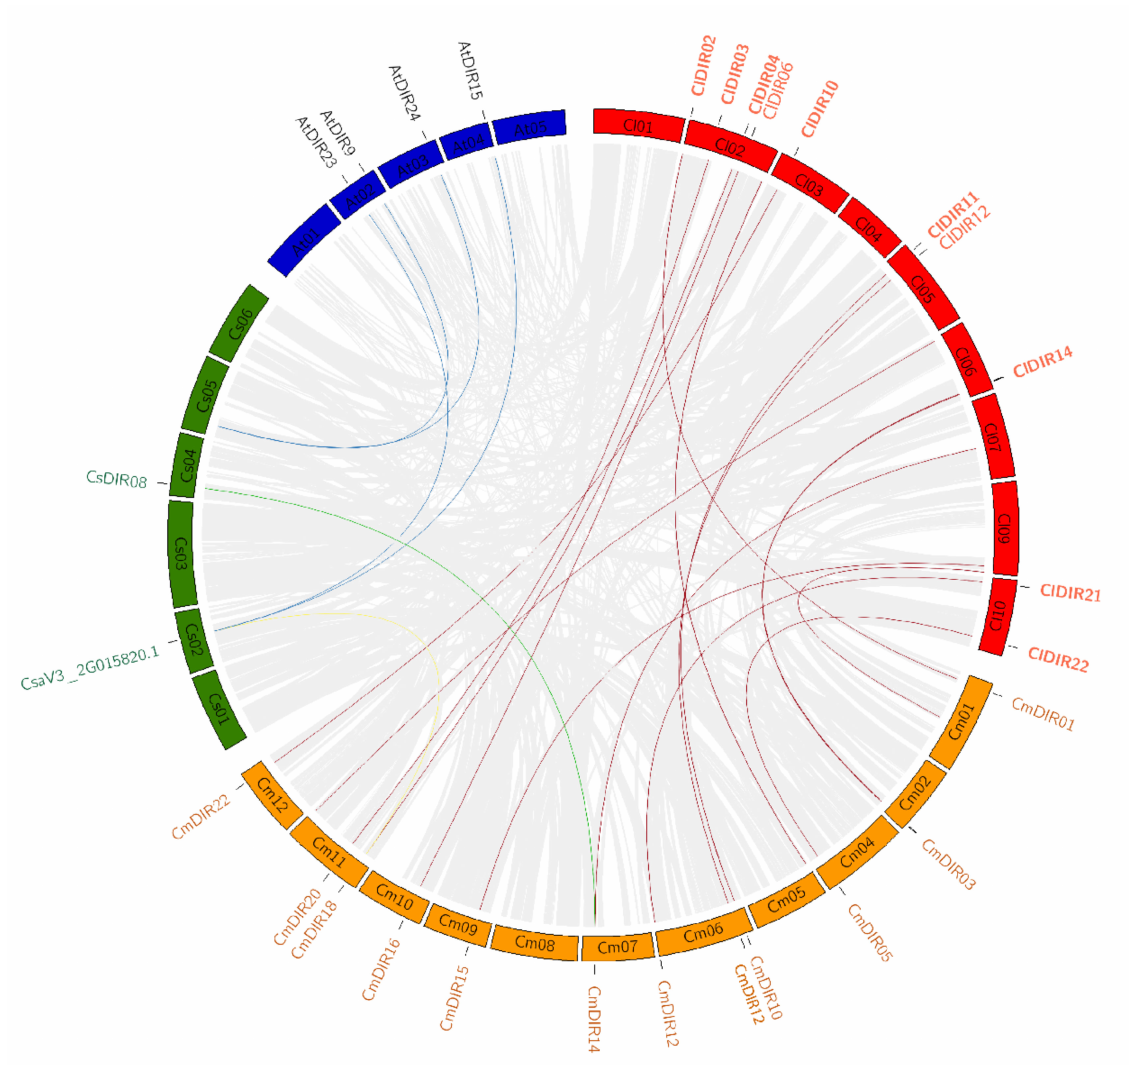
Figure 6. Synteny analysis of dirigent genes of different cucurbitaceous species. In total, 12 DIR genes on nine chromosomes of C. lanatus , 11 DIR genes on 11 chromosomes of C. melo , 2 DIR genes on 6 chromosomes of C. sativus . Background lines of gray color represent all the collinear blocks within different species, while red color is used for C. lanatus , green color for C. sativa , orange for C. melo , and blue shades were used for Arabidopsis. The colored lines from one species to another species depict the orthologous relationships of DIR genes of different